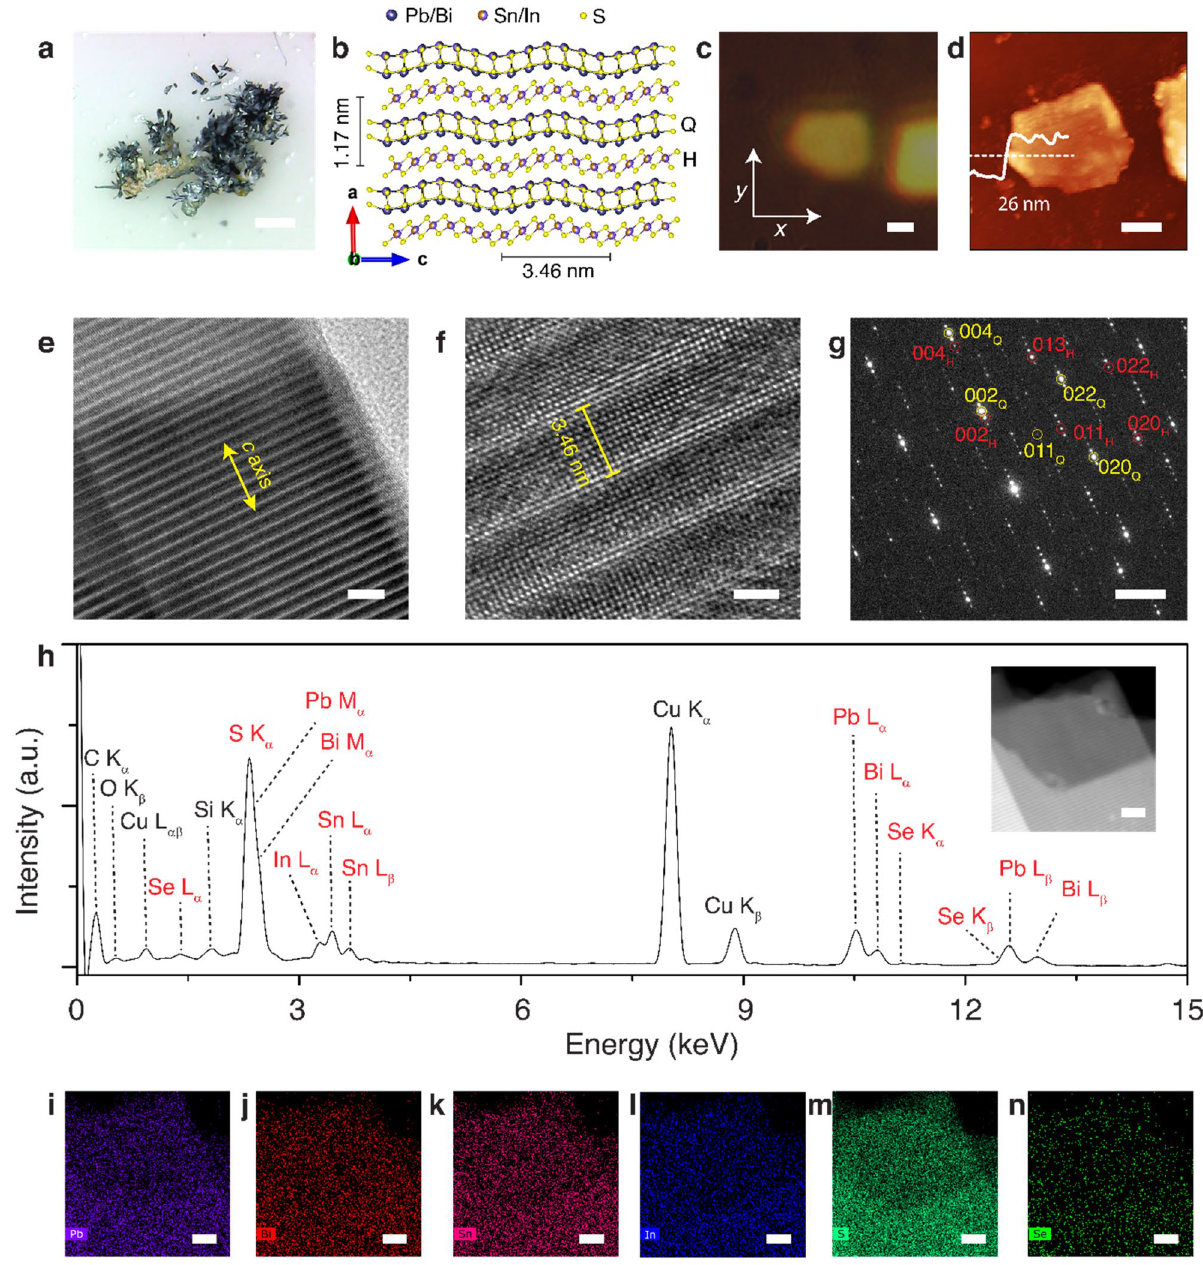
Figure 1. ( a ) Optical image of abramovite mineral rock, where silvery black metallic twisted and distorted lamellar crystals in several radiating aggregates are visible. Scale bar is 1 mm. ( b ) Schematic diagram of the abramovite crystal structure with vdW stacking of alternating Pb 2 BiS 3 (Q) and SnInS 4 (H) 2D material layers. ( c ) Reflection microscope image of one mechanically exfoliated abramovite thin flake. Scale bar is 1 µm. ( d ) AFM image of the same flake confirming the thickness of 26 nm. Scale bar is 1 µm. ( e ) TEM image of an exfoliated abramovite flake with the characteristic rippling fringes along the c -axis of the crystal. Scale bar is 10 nm. ( f ) Magnified HRTEM image showing the atomic arrangements. Scale bar is 2 nm. ( g ) Corresponding SAED pattern with diffraction spots related to Q-layer (yellow color) and H-layer (red color). Sale bar is 2 nm −1 . ( h ) Averaged EDXS spectrum from the abramovite crystal shown in the dark-field TEM image in the inset. ( i – n ) Corresponding TEM-EDXS elemental maps of the main elements Pb, Bi, Sn, In, S, and Se. Scale bars are 20